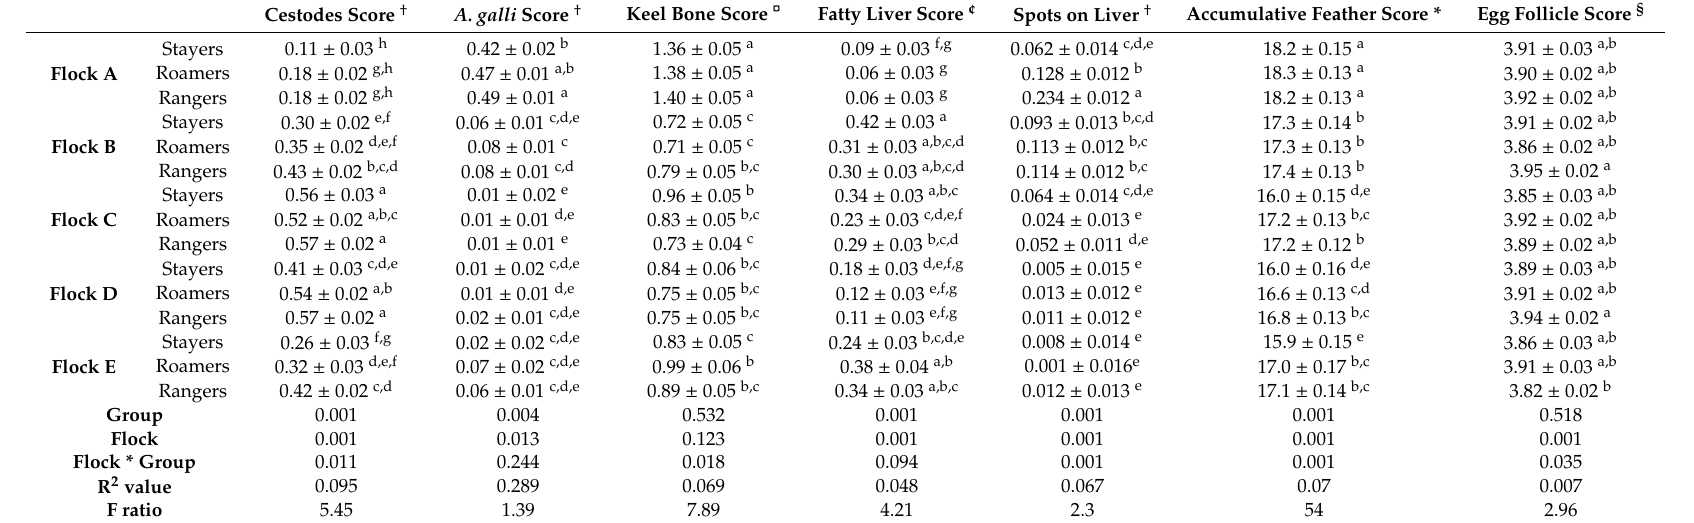
Table 4. The mean ± SEM scores and statistical analysis of health and welfare parameters obtained from stayers, roamers and